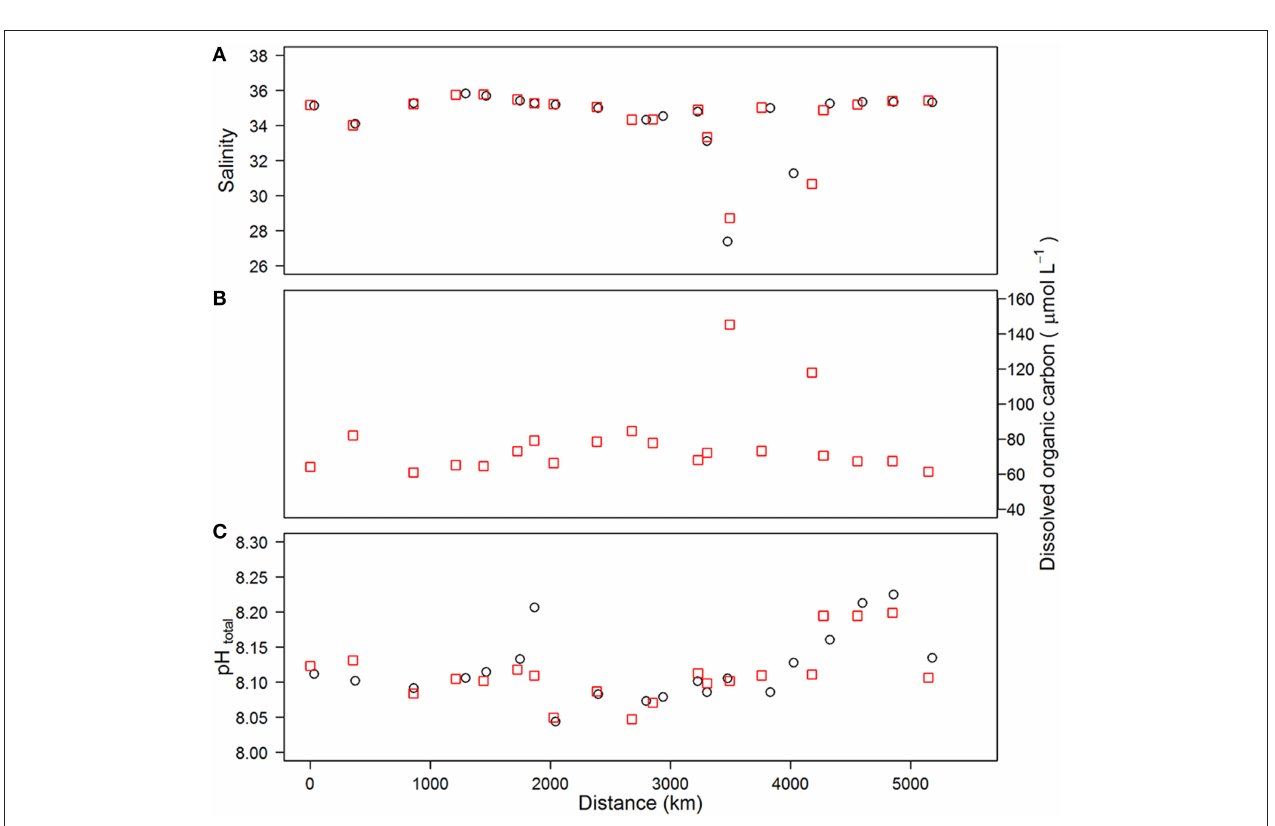
FIGURE 2 | Salinity (A), dissolved organic carbon (B) and pH (C) obtained for CTD samples (red squares) and underway samples (black circles) plotted as a function of distance along the cruise track.